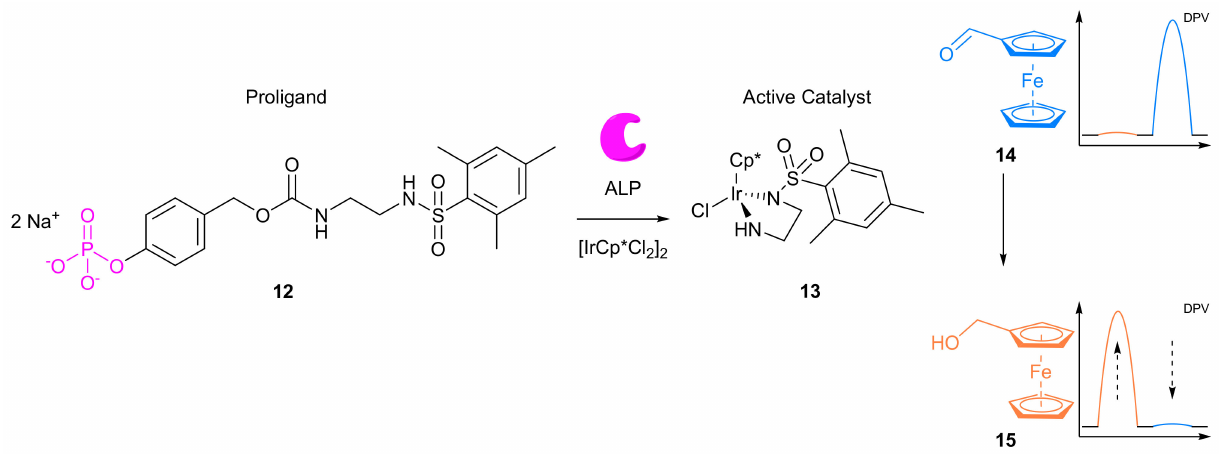
Figure 49. Schematic representation of a proligand-based label amplification chemodosimeter for the detection of alkaline phosphatase